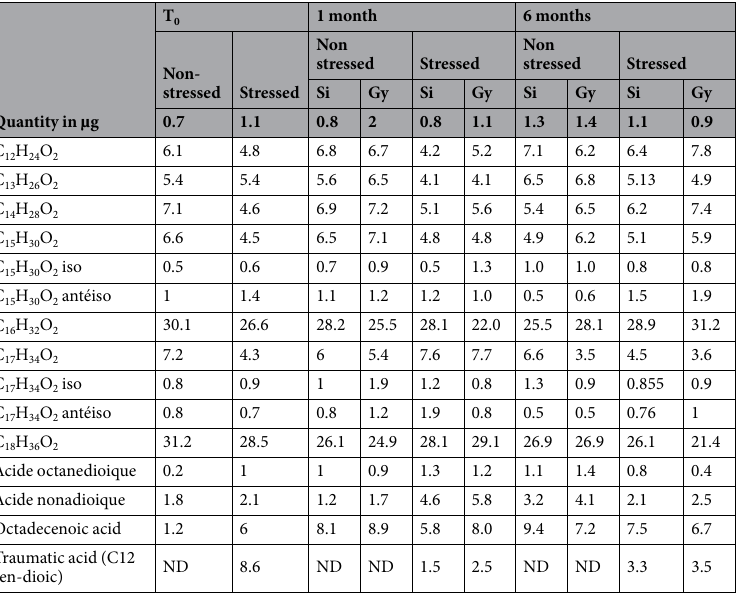
Table 3. Relative abundance of Yersinia fatty acids detected by GCMS analysis, after 1 month and 6 months of mineralization in silica (Si) and gypsum (Gy), either for cells exposed to dessication + X-rays, or to non-stressed Yersinia . ND = Not